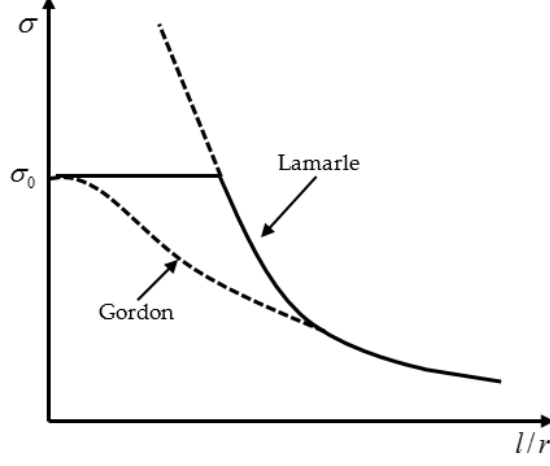
Figure 2. Comparison of design curves for compression members.